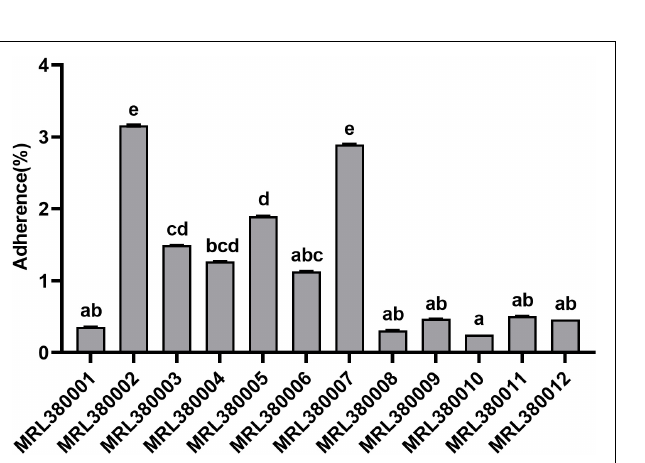
FIGURE 5 | Number of virulence genes among different CRISPR types of laboratory STEC strains.